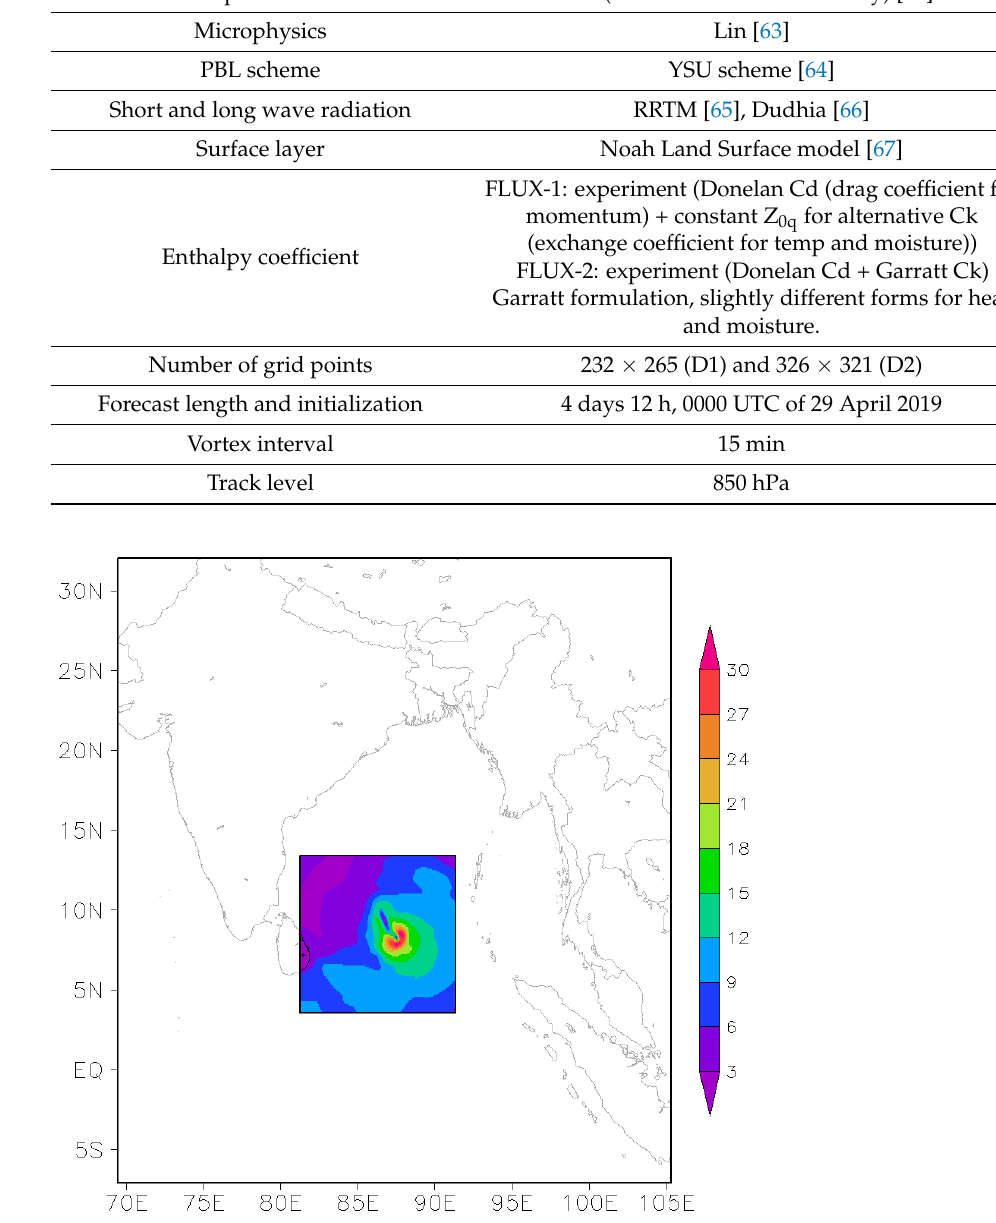
Figure 3. Double nested model domains (15 km and 3 km) with inner domain are taken as the moving nest; the shaded region shows the wind field (in m/s) during initialization at 0000 UTC on 29 April 2019.